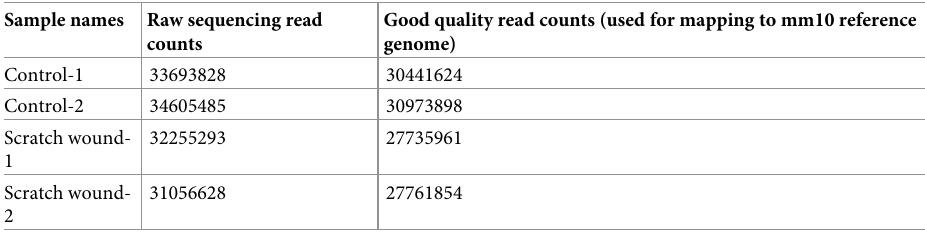
Table 1. NGS read counts. Sample names Raw sequencing read